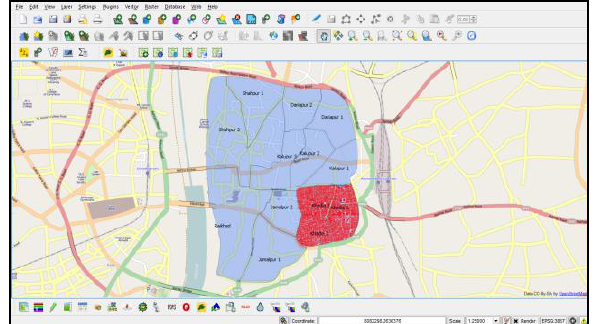
Figure 5. Geo-referenced map of Khadia along with other ward